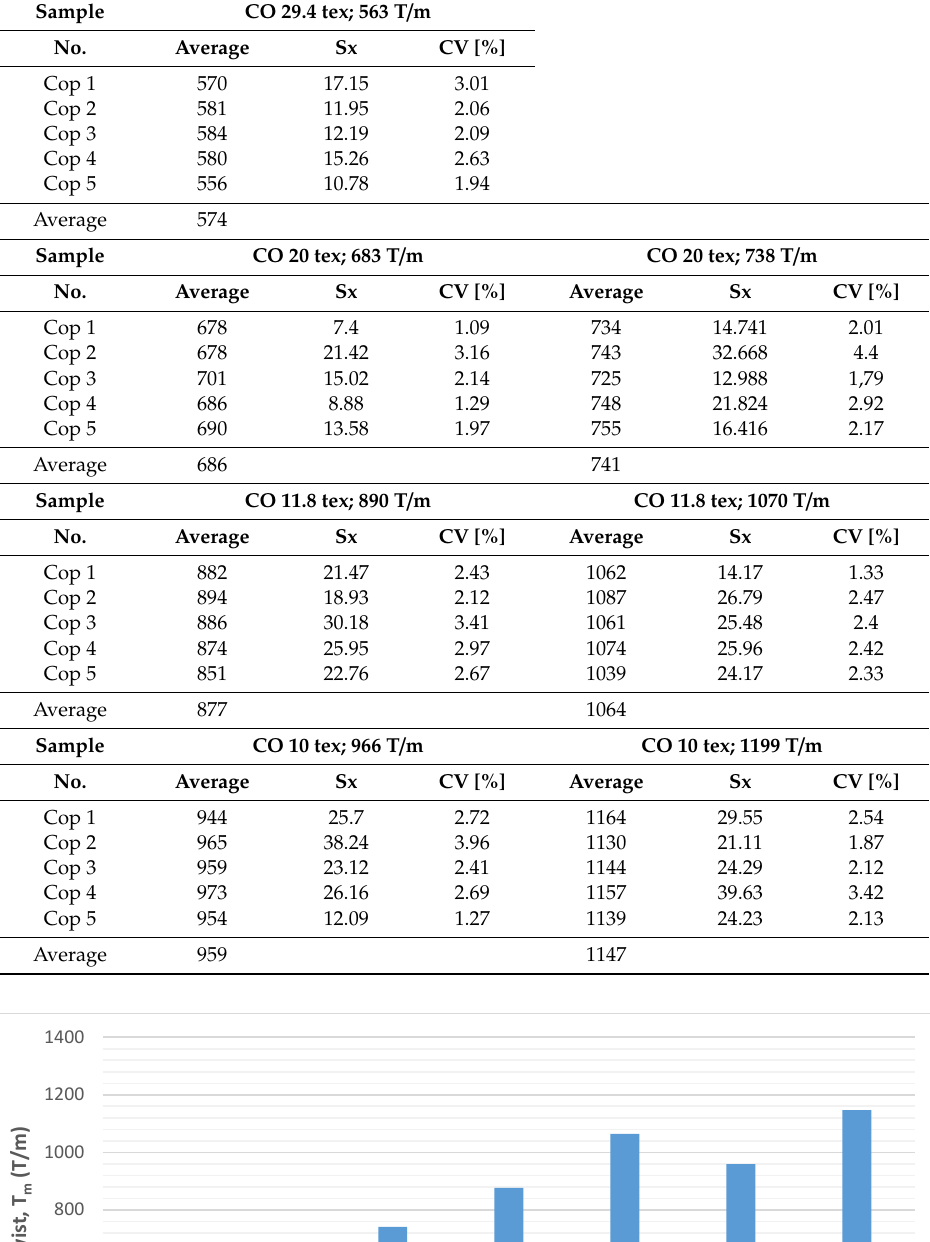
Table 6. Measured number of turns per meter of analyzed yarns.